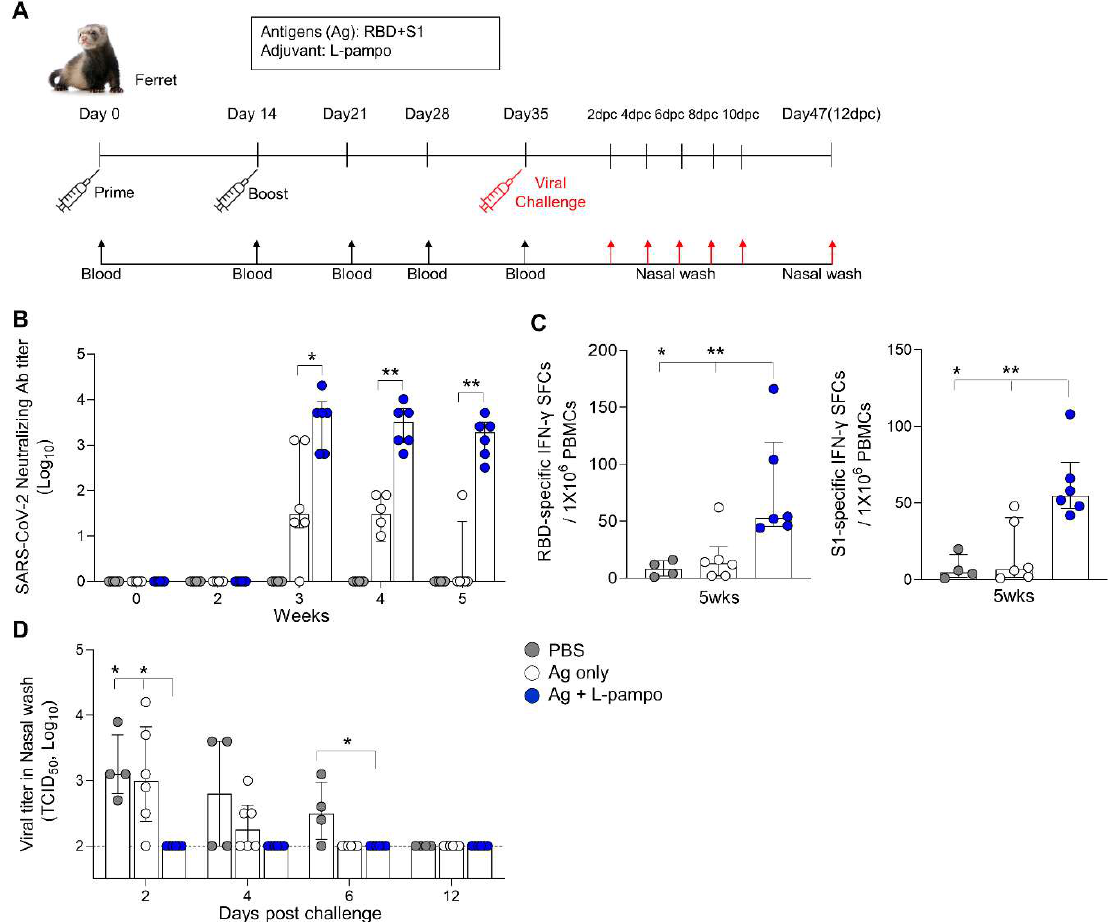
Figure 5. RBD and S1 antigens with L-pampo induce robust humoral and cellular responses in the ferret model. ( A ) A schematic of the immunization and virus challenge strategy in the ferret model. Ferrets (total n = 16, n = 4/PBS; n = 6/Ag only; n = 6/Ag + L-pampo) were immunized with the SARS-CoV-2 antigens (RBD and S1 with 30 µ g per each) with L-pampo i.m. on day 0 and day 14. The antigen-only and PBS groups were as controls. On day 35, ferrets were intranasally challenged with 10 5.5 50% tissue culture infective doses (TCID 50 / mL ) SARS-CoV-2 (Korea Centers for Disease Control and Prevention; resource no. 43326) under anesthesia. Blood was collected every week for 5 weeks from the first immunization. After virus challenge, the nasal wash was collected on days 2, 4, 6, 8, 10, and 12. ( B ) Neutralizing antibody production on day 35 prior to challenge of virus. ( C ) On day 35, ferret PBMCs were stimulated with the RBD or S1 antigen and RBD or S1-specific IFN-γ-secreting cells were analyzed as SFCs by ELISPOT assay. ( D ) Viral load in nasal wash on days 2, 4, 6, and 12 after virus challenge by using a TCID 50 assay. Dotted lines represent lower limits of detection. Data shown are median ± IQR. Each dot represents an individual ferret. Data reflect 2 independent experiments (n = 2/PBS group; n = 3/Ag only or Ag + L-pampo group in single experiment). * p < 0.05; ** p < 0.01; two tailed Mann–Whiteny test ( B ); one way ANOVA with the Tukey’s test ( C , D ). Table 1. Ferrets immunized with L-pampo protect against SARS-CoV-2 virus challenge. Immunization Group Virus Replication 2 dpc